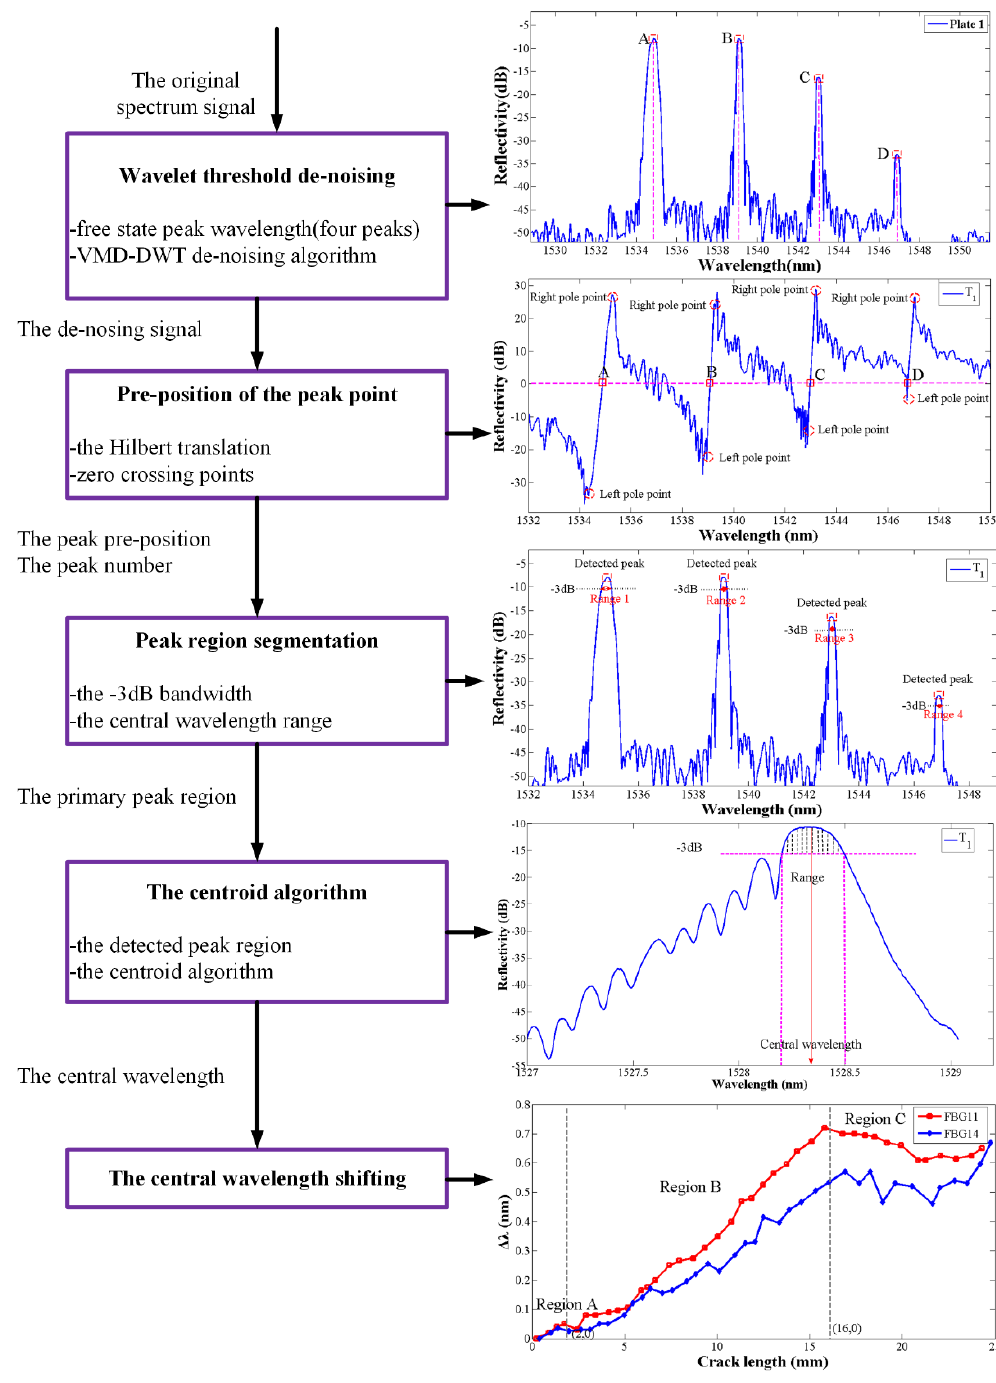
Figure 1. Flow chart of the primary peak detection algorithm.